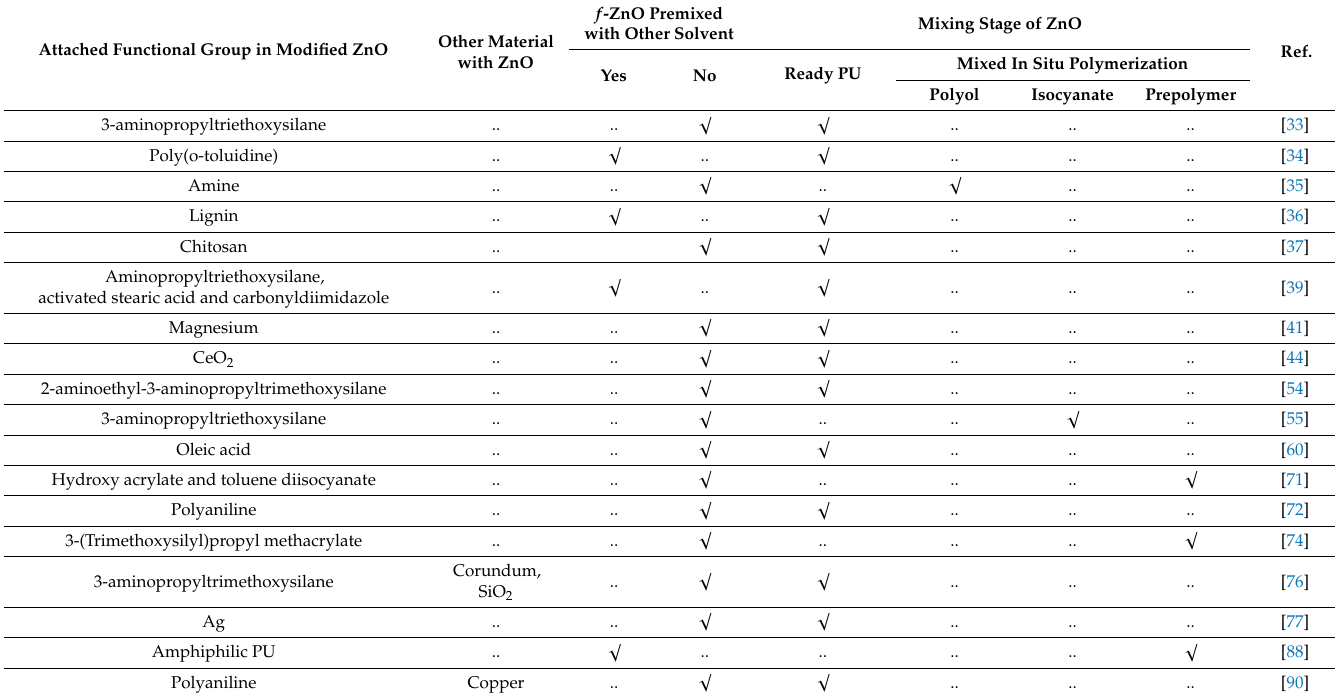
Table 4. Mixing of functionalized ZnO during PU / ZnO dispersion